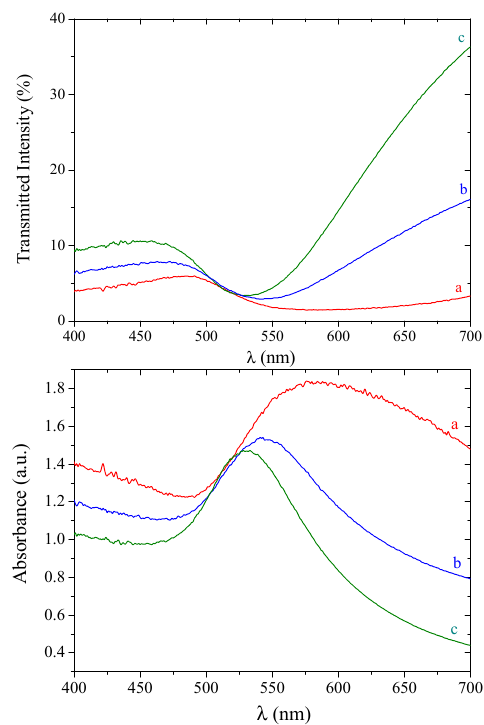
Figure 2. Transmittance/absorbance spectra of DR100 UHMWPE/gold nanocomposite in plane polar- light. The angle between the polarization direction of the light and the drawing direction of the film ( θ ) is (a) 0 ◦ (red curve), (b) 45 ◦ (blue curve), and (c) 90 ◦ (green curve).